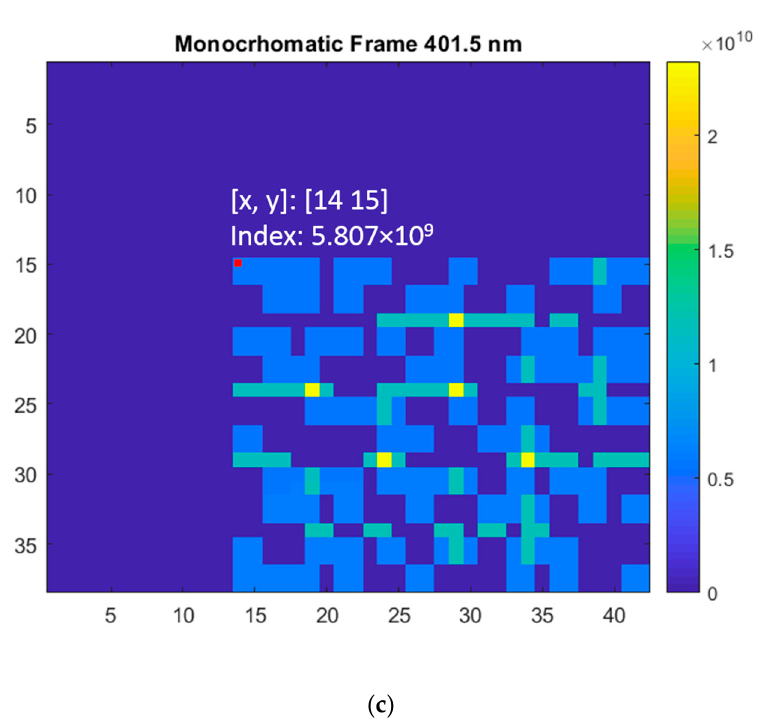
Figure 11. The false color intensity image of the coded aperture with illumination by monochromatic light of 401.5 nm wavelength at air gaps of ( a ) 4.24 mm, ( b ) 4.64 mm, and ( c ) 5.04 mm. The intensity maps of the three patterns are different due to the different light dispersion conditions at these three air gap displacements in the DP-CASSI system.